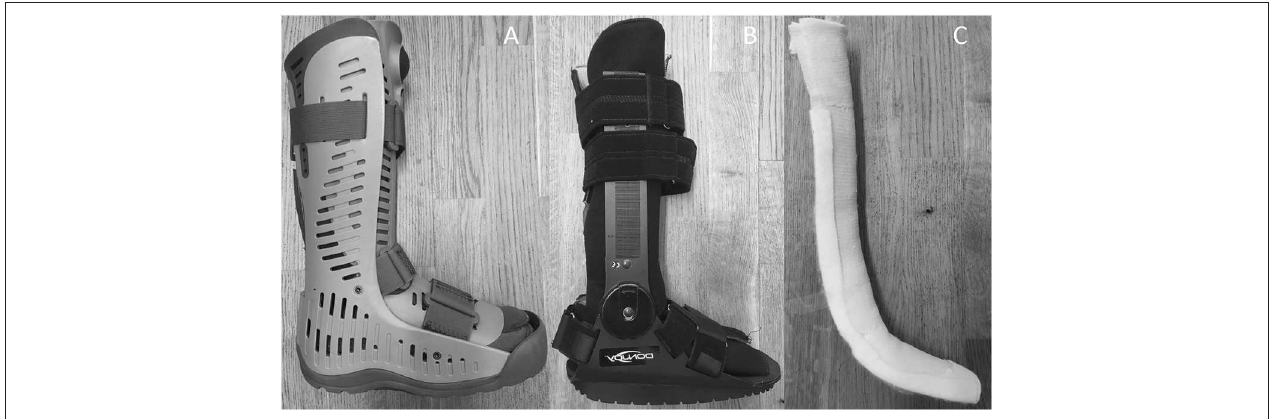
FIGURE 2 | The three different designs of ankle foot orthoses that were tested. (A) rigid AFO, (B) adjustable AFO, and (C) dorsal brace.